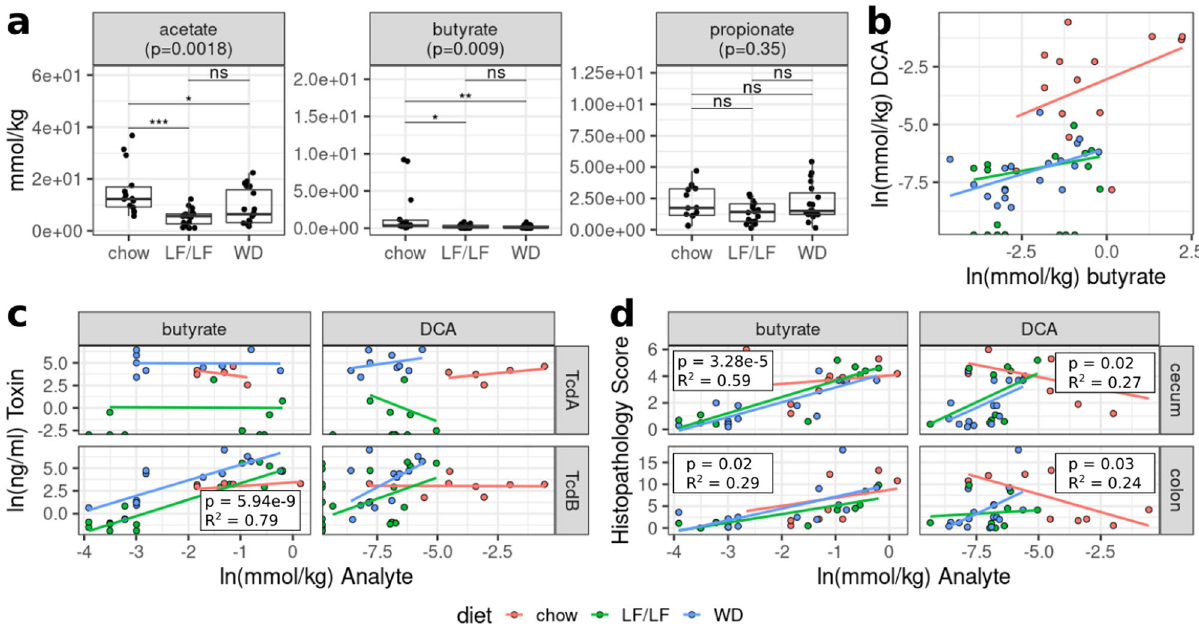
Fig. 4 Relationships between microbial metabolites (SCFAs and the secondary bile acid DCA) and diet, toxin, and in fl ammation. a Cecal levels of the SCFAs acetate, butyrate, and propionate. p -values were determined using a Kruskal – Wallis with Dunn ’ s post hoc test. Median and IQR indicated. (* p < 0.05, ** p < 0.01, *** p <0.001). b Multiple linear regression of DCA levels as a function of butyrate and diet. Model = ln(DCA) ~ln(butyrate) + diet + ln(butyrate)*diet. R-squared 0.855 p < 0.0001. c Multiple linear regressions of C. dif fi cile toxin TcdA and TcdB concentrations against butyrate and DCA while controlling for dietary interactions. d Multiple linear regressions of cecal or colonic histology against butyrate and DCA while controlling for dietary